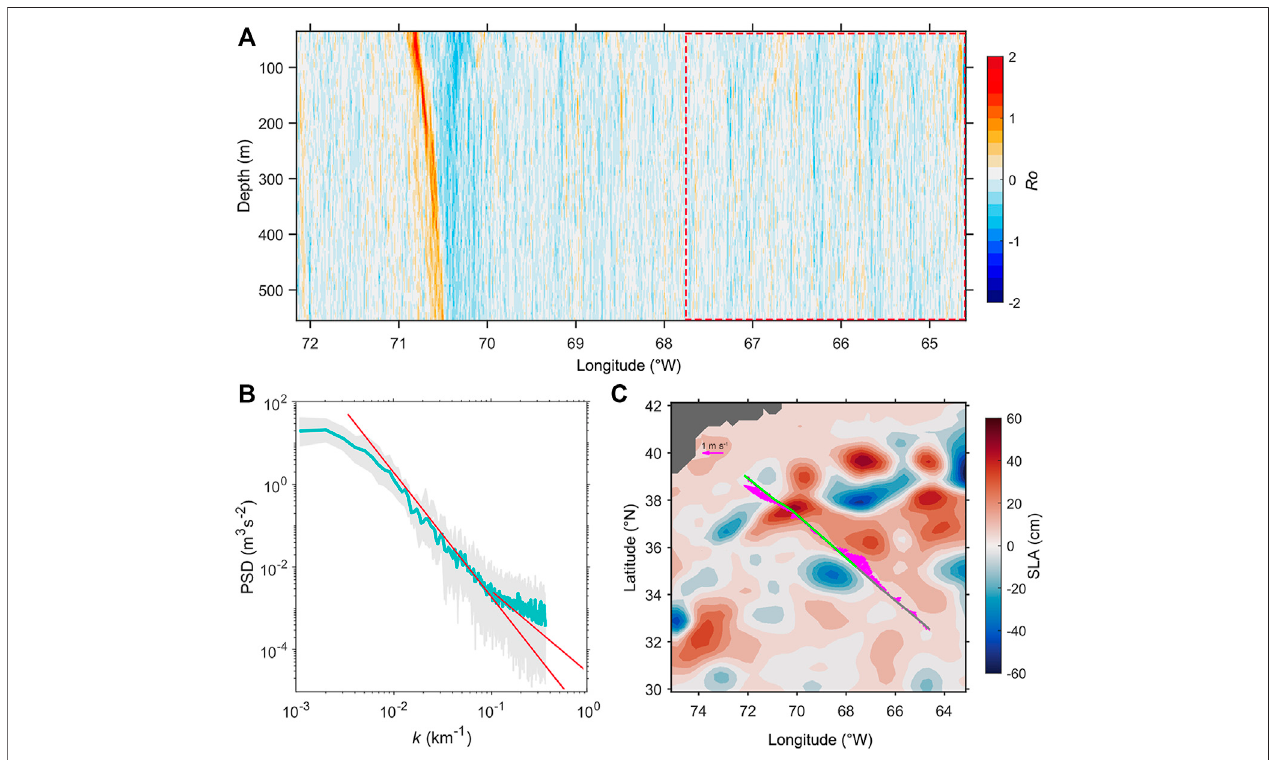
FIGURE 9 | Information of case 200907. (A) Section of Rossby number, where the red dashed box marks the part of section being examined; (B) kinetic energy spectra;thelightgraycurvesareoriginalspectraateverydepth,thegreencurvesdenotetheaveragedstate,andtheredlinesarereferencesof k − 3 and k − 2 ; (C) SLAmap (cm) and surface velocity vector (m s − 1 , magenta arrows); the green curve denotes the section, and the gray curve is the part being examined.